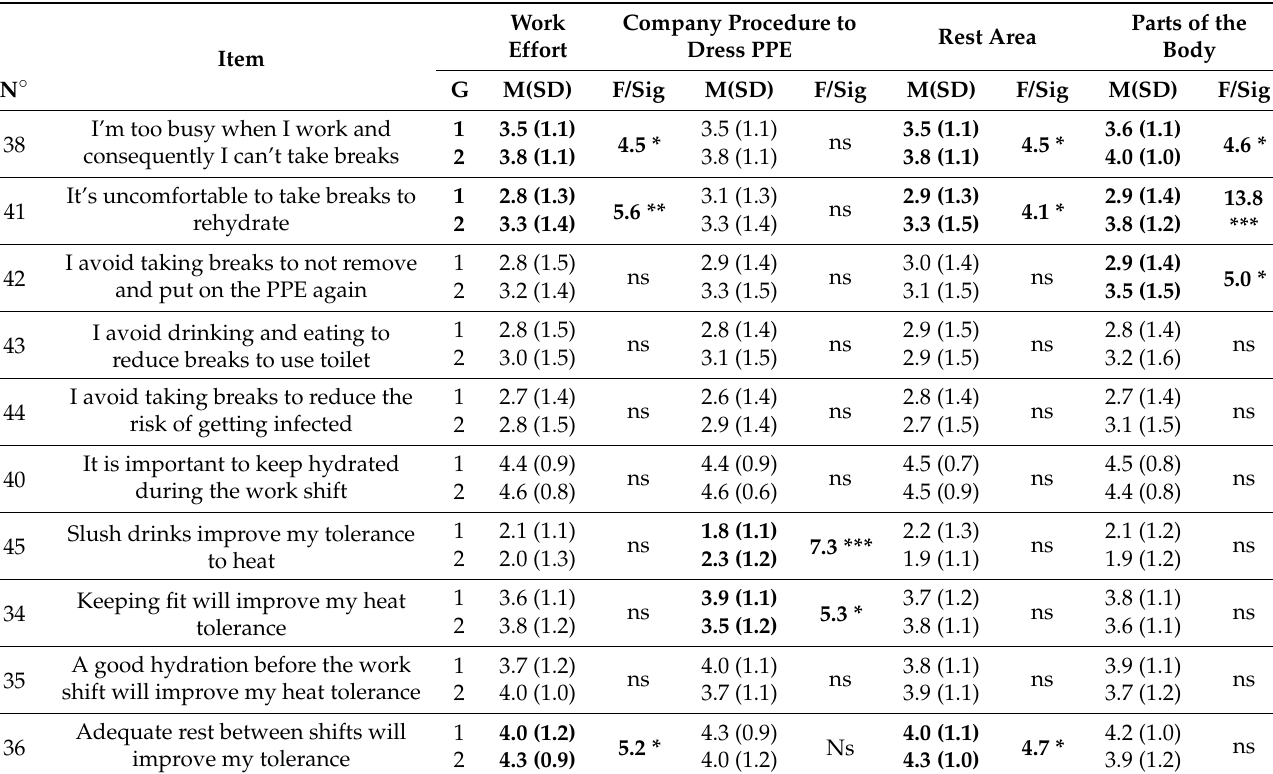
Table 6. Difference between groups concerning issues related to worker’s behavior and awareness of good practices to increase the heat